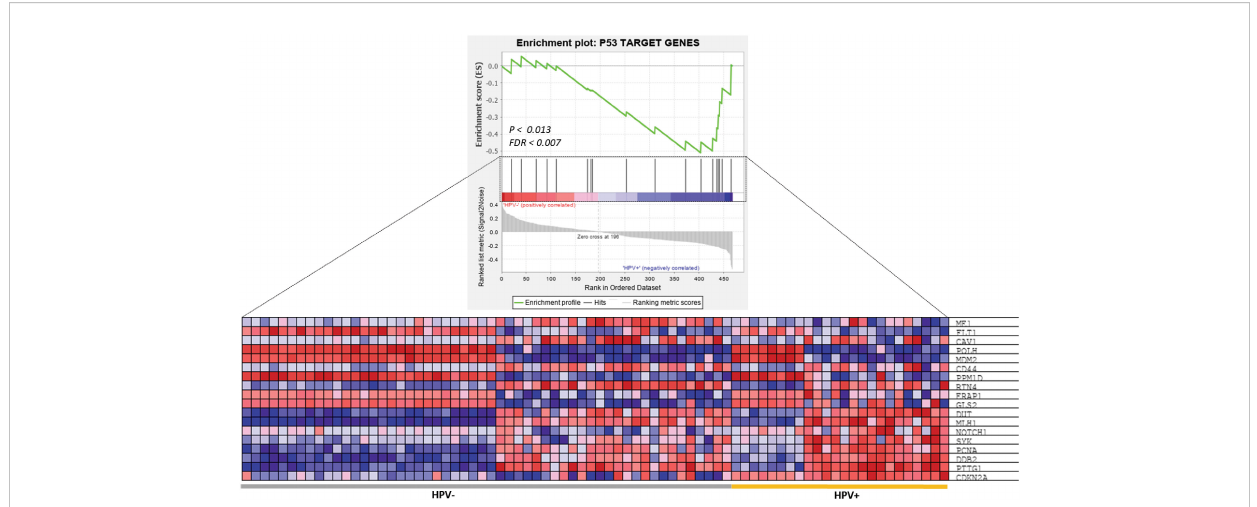
FIGURE 4 GSEA of P53 target genes in HPV + and HPV - HNSCC patients. The top image shows the distribution of P53 target genes based on the rank position after enrichment analysis. The bottom image is a heatmap presentation showing the expression pro fi ling of 18 enriched P53 target genes between HPV + and HPV - HNSCC samples.